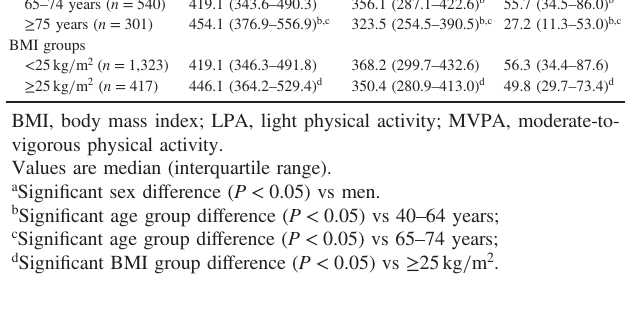
Number of prolonged Time spent in prolonged sedentary bout a sedentary bout a (times = day)